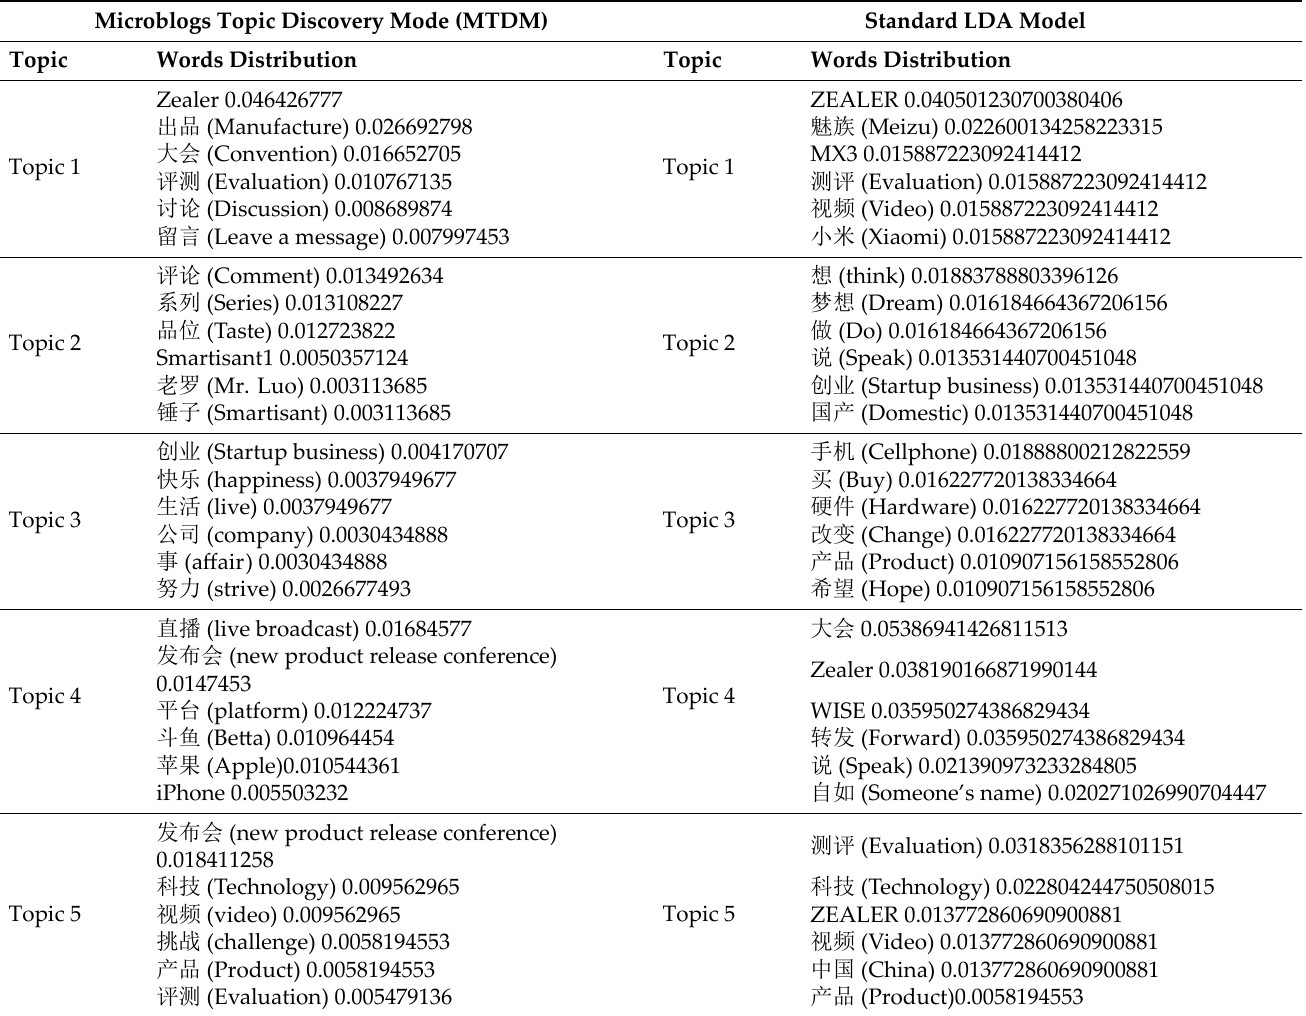
Table 5. The result samples of MTDM and Standard LDA.